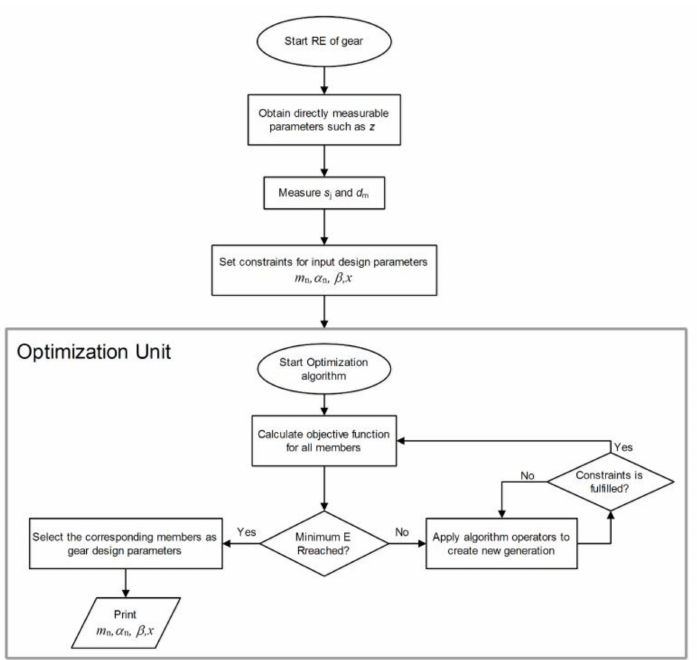
Figure 2. Flowchart of the proposed RE of gear